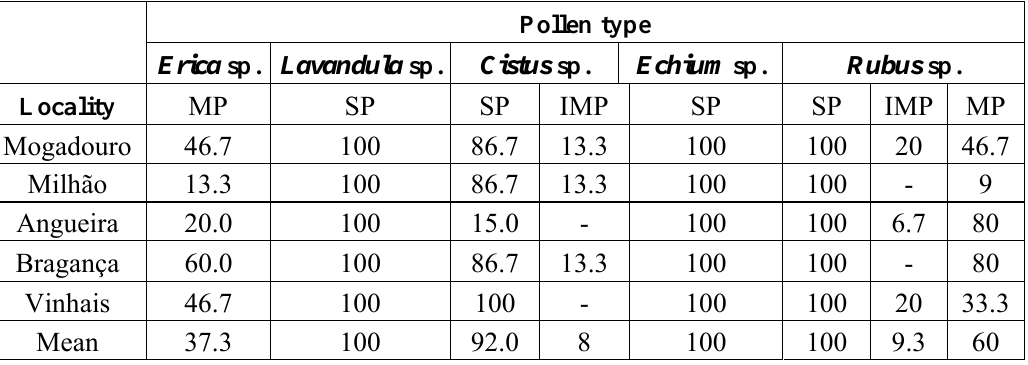
Table 1. Frequency classes of pollen types in organic